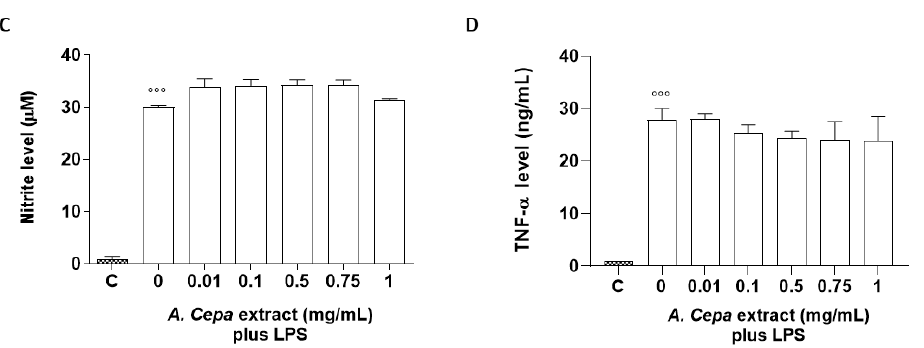
Figure 4. Effect of the A. cepa extract on LPS-induced PGE 2 , IL-1 β , nitrite, and TNF- α production. J774 cells were pre-treated for 2 h with increasing concentrations of the extract (0.01, 0.05, 0.1, 0.5, 0.75, and 1.0 mg/mL) prior to LPS stimulation (10 µ g/mL) for 24 h. Unstimulated J774 cells acted as a negative control. Nitrites ( C ), stable end-products of NO, were measured in the supernatants by the Griess reaction, whereas PGE 2 ( A ), IL-1 β ( B ), and TNF- α ( D ) were measured by ELISA. ◦◦◦ p < 0.001 vs. unstimulated cells C, *** p < 0.001, ** p < 0.01, and * p < 0.05 vs. LPS alone.